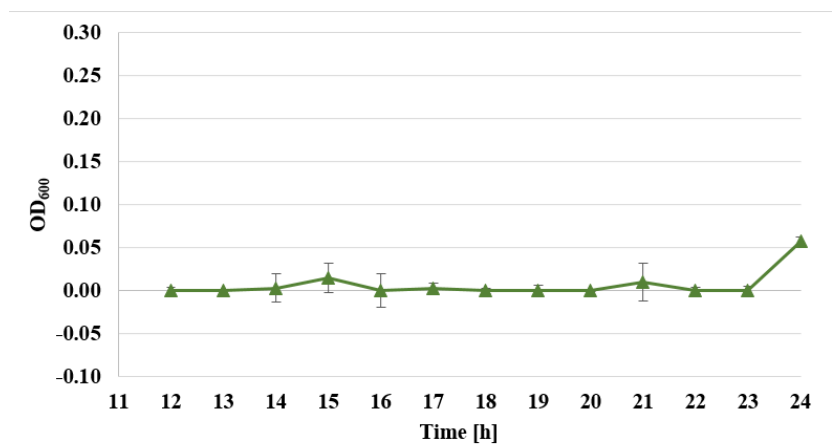
Figure 4. Changes of absorbance in Alamar Blue test for the strain S. epidermidis ATCC 35984, exposed to the activity of nanosilver particles with sizes of 10 nm and a concentration of 7 µg/mL between the 12th and 24th hour ( λ = 600 nm).